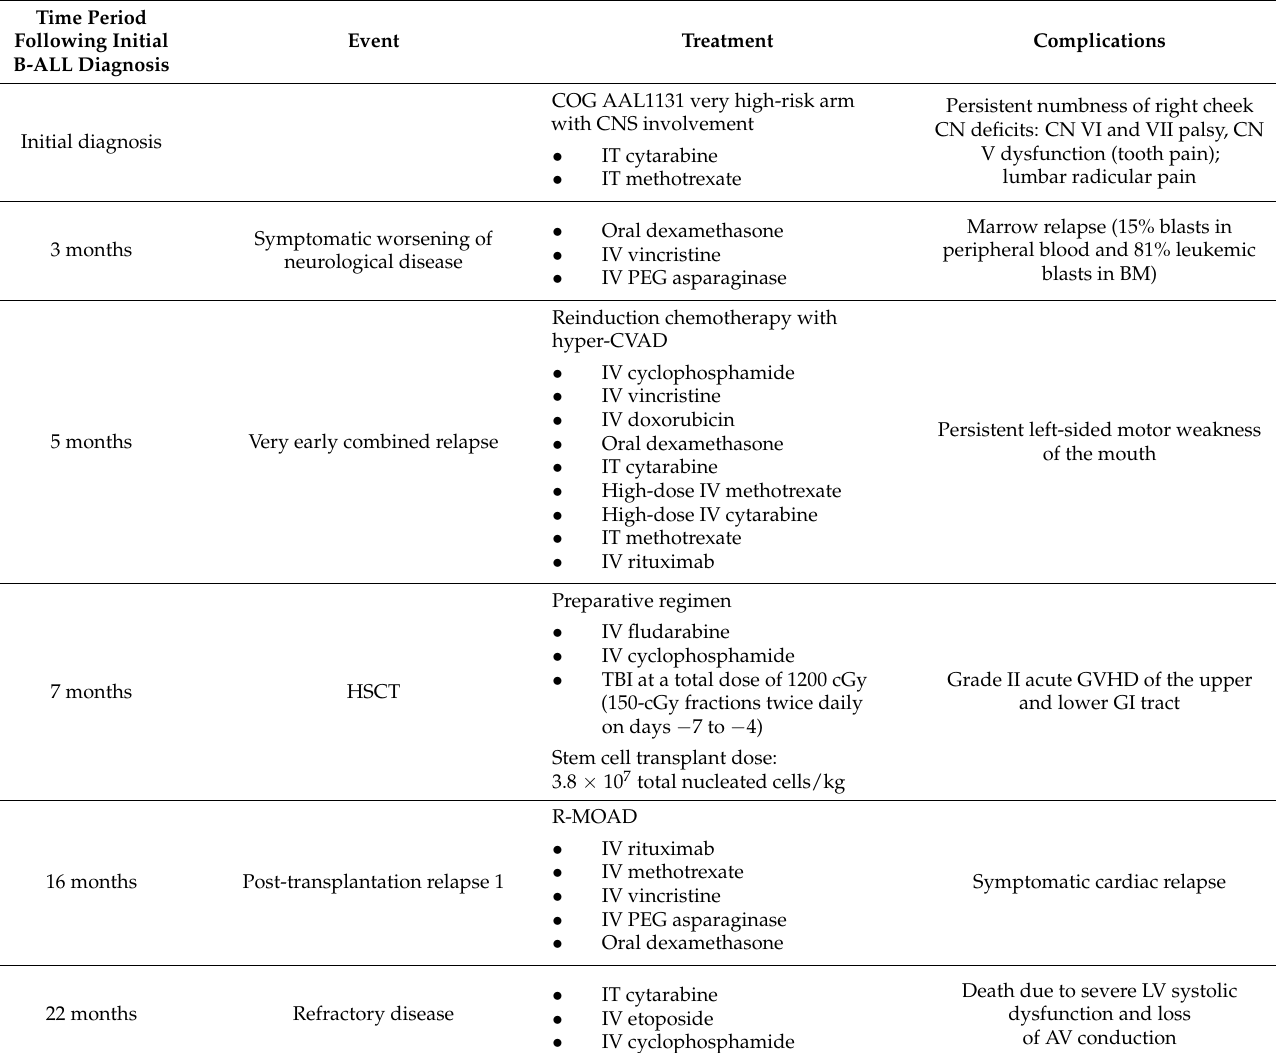
Table 2. Summary of the patient’s treatment regimens and associated